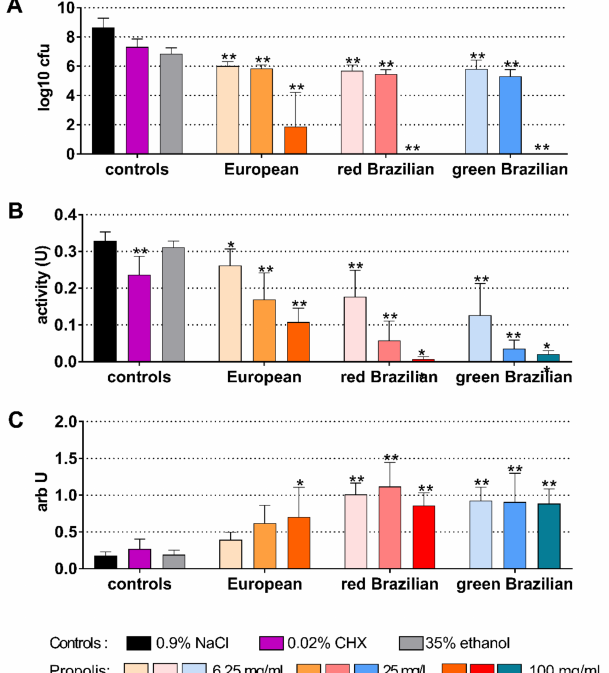
Figure 4. Activity of the different ethanolic extracts of propolis (European and red and green Brazilian) on colony forming units (cfu) ( A ), metabolic activity ( B ), and quantity ( C ) on a 48 h cariogenic biofilm. */** p < 0.05/ p < 0.01 vs. control 0.9%